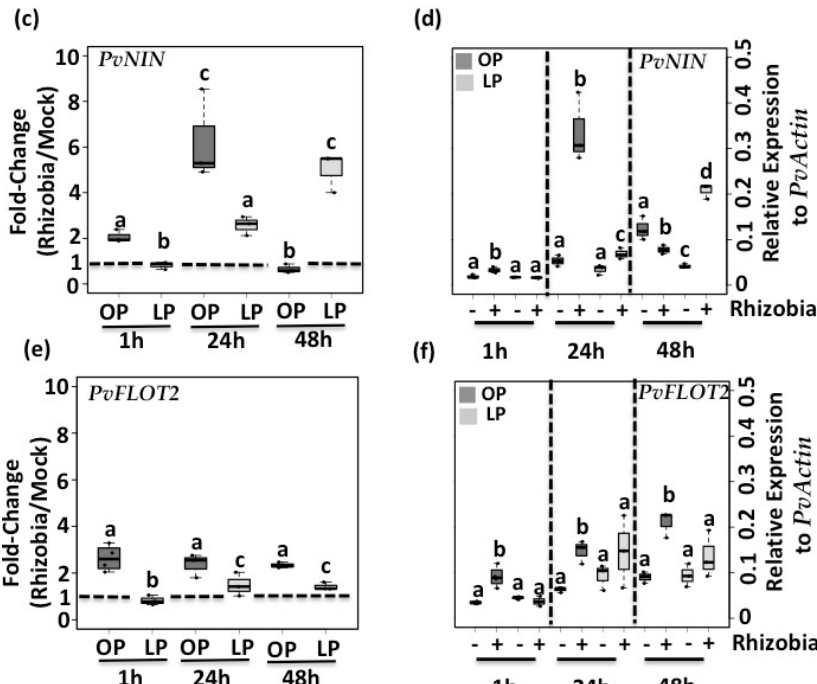
Figure 3. Pi deficiency reduces the activation of early symbiotic genes. Rhizobia-triggered expression of PvNSP2 ( a ), PvNIN ( c ) and PvFLOT2 ( e ) genes in common bean seedlings growing under OP or LP conditions and inoculated with mock or rhizobia. Data showed are the fold-changes (e.g., OPR/OPM) obtained from four independent replicates, each one containing susceptible zones from four different plants. Dashed line shows basal expression (e.g., no induction triggered by rhizobia). Expression levels of PvNSP2 ( b ), PvNIN ( d ) and PvFLOT2 ( f ) genes in common bean seedlings grown under OP (dark-gray) or LP (light-gray) conditions and inoculated with mock ( − ) or rhizobia (+). Data showed was obtained from four independent replicates, each one containing susceptible zones from four different plants. Box plots represent first and third quartile (horizontal box side), minimum and maximum (outside whiskers). One-way ANOVA, followed by a Tukey honest significant difference (HSD) test was performed ( p -value < 0.01). Statistical classes sharing a letter are not significantly different.